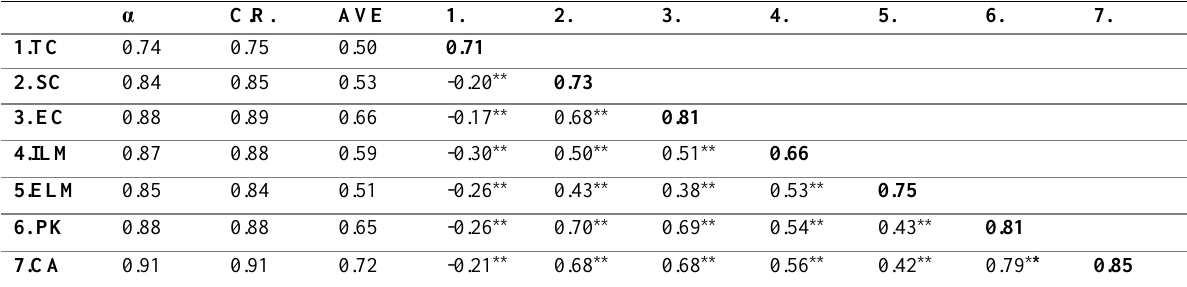
Table 1 : Correlations, Composite Reliability, Convergent Validity, and Discriminant Validity